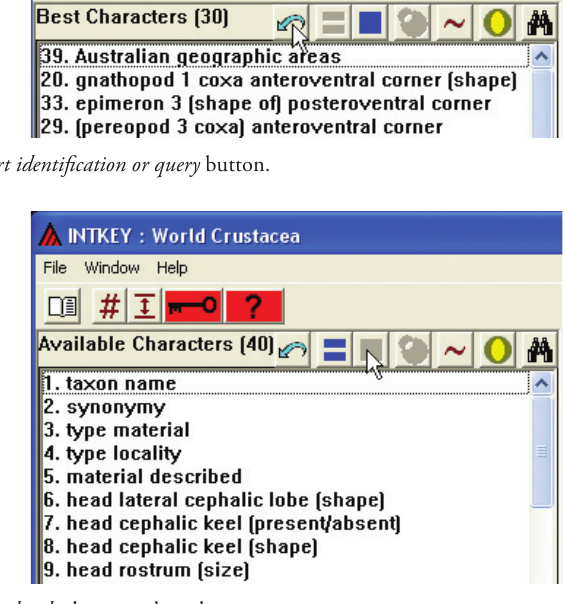
Figure 43. Natural order button